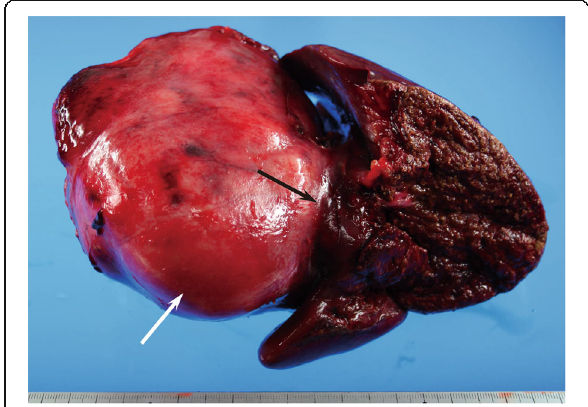
Fig. 4 Resected specimen. The resected tumor (white arrow) has a lobulated contour and white-colored surface. The tumor tenaciously adheres to the Glisson capsule (black arrow)